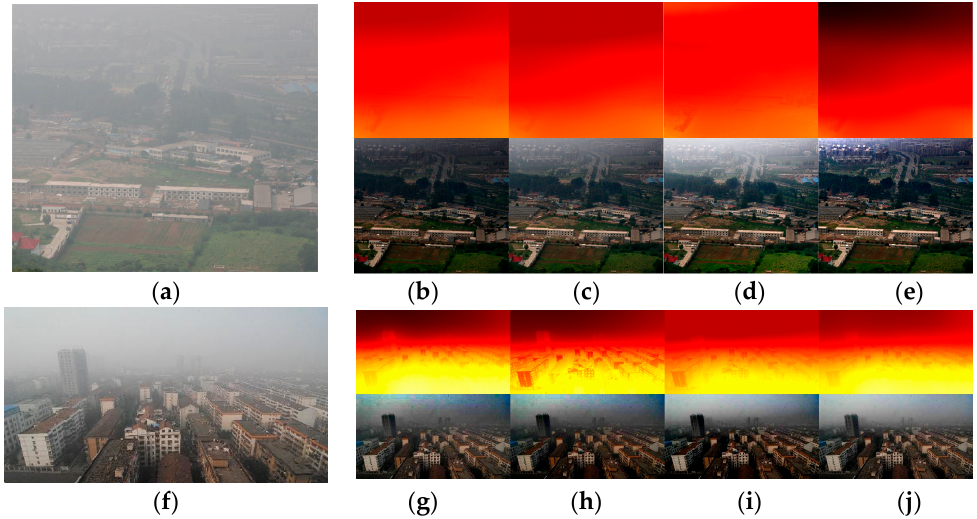
Figure 13. Comparison of the transmission maps that are estimated via [12,21,26] and our method. ( a ) A dense haze image without sky region. ( b – e ) From left to right; top: the transmission maps that are estimated via [12,21,26] and our method, respectively; bottom: the corresponding recovered images. ( f ) A hazy image with sky region. ( g – j ) From left to right; top: the transmission maps that are estimated via [12,21,26] and our method, respectively; bottom: the corresponding recovered images.